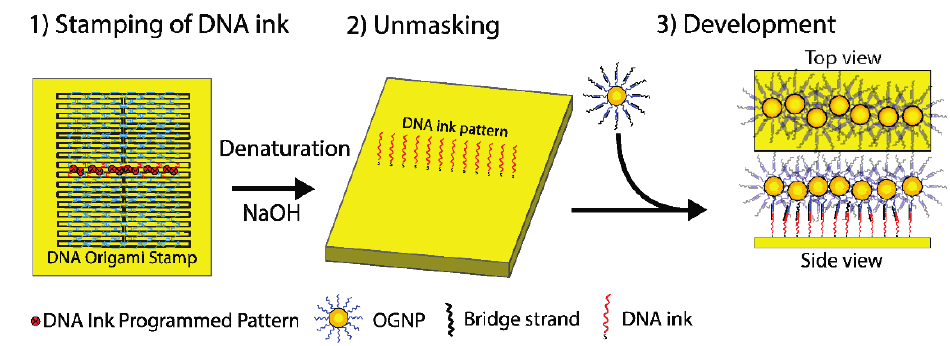
Figure 1. DNA-origami stamping process of a linear DNA ink programmed pattern on gold surfaces. The protocol describes the three basic steps of the stamping (1), unmasking (2), and development (3). (1) DNA-origami stamp is adsorbed on a gold surface. Then the DNA stamp is left over the surface until the thiol groups of the ink and anchor staples react with the gold surface; (2) The frame of the DNA stamp is denatured with NaOH and rinsed out to expose the DNA ink pattern. The DNA bridge was annealed directly to the OGNP; (3) Finally, the pattern is developed with the annealing of the OGNP-bridge sequence to the